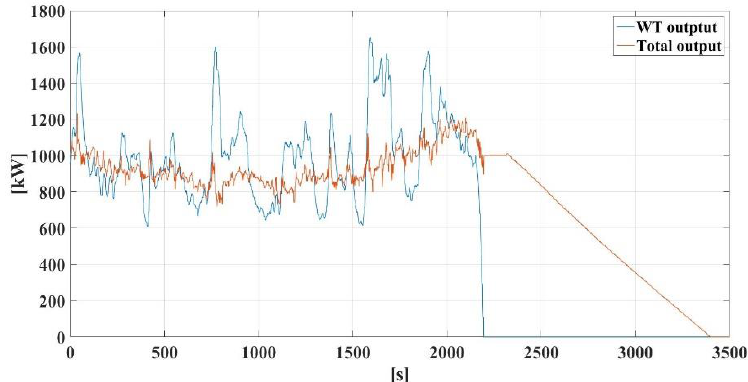
Figure 12. Field test result 2: wind and total output power.